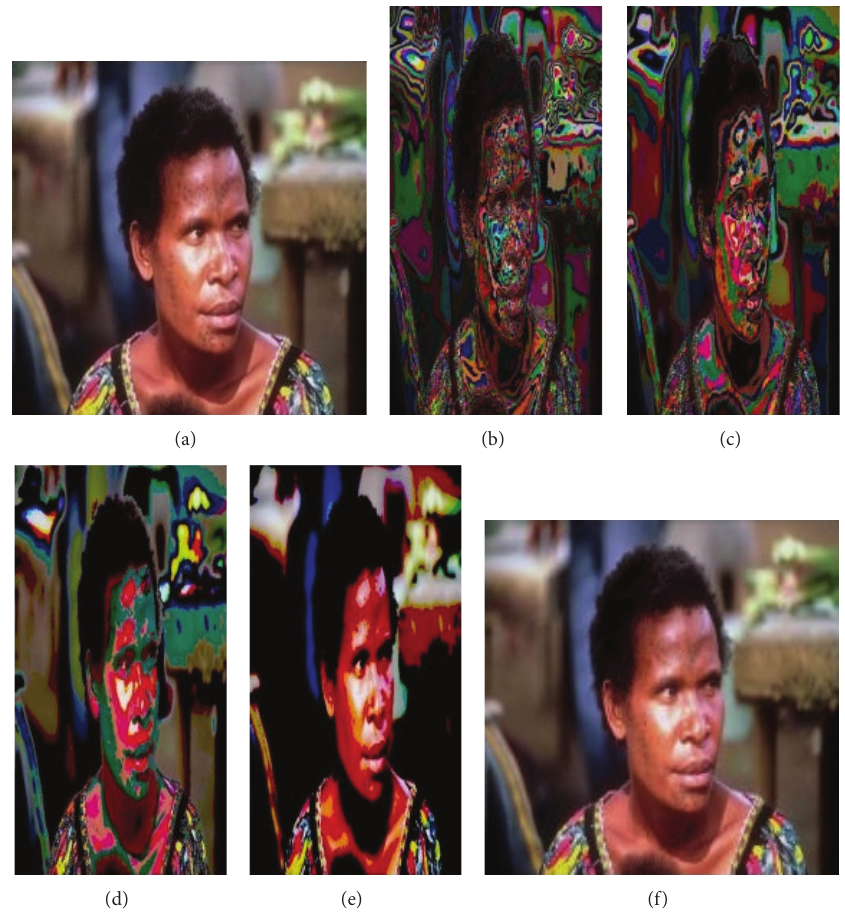
Figure 2: (a) Original image, (b) image of bit plane 5, (c) image of bit plane 6, (d) image of bit plane 7, (e) image of bit plane 8, and (f) amalgamated image of bit planes 5, 6, 7, and 8.